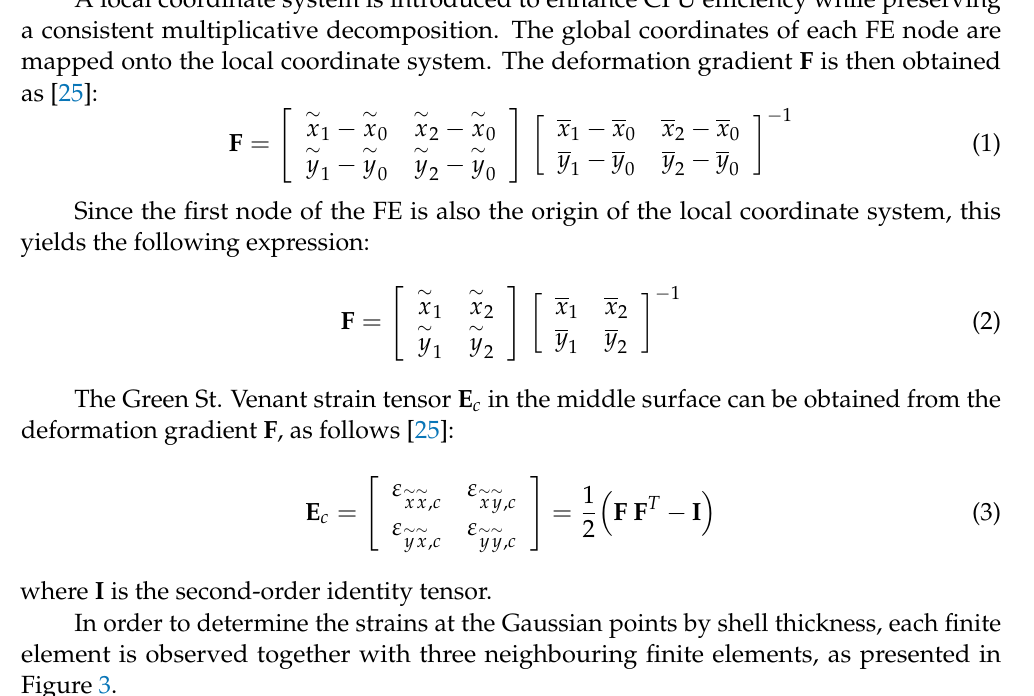
Figure 2. Current and initial coordinates of finite element nodes.